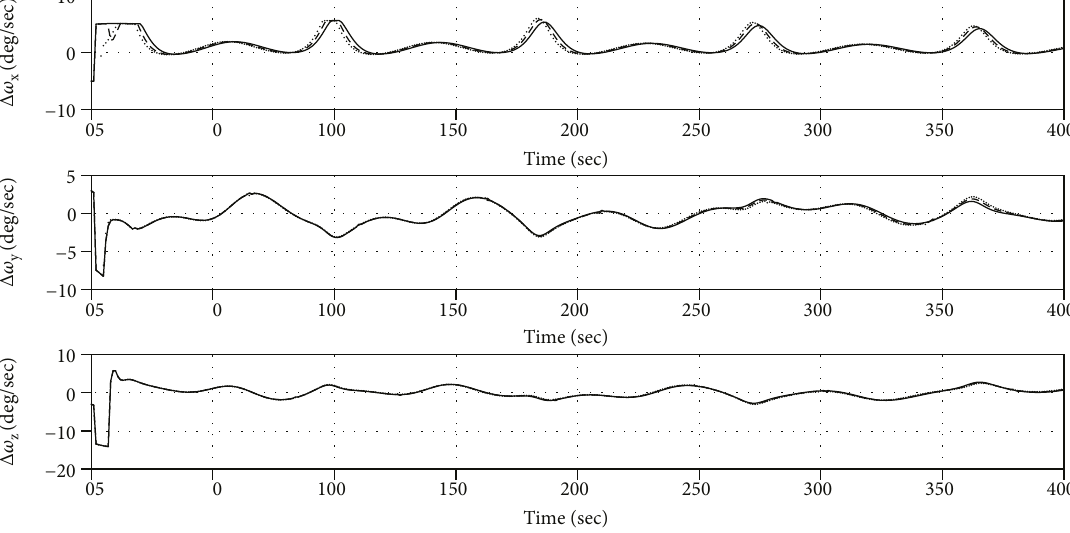
Figure 13: Measurement errors for exact [ J ] (solid line), 10% error on J fi ltering phase.